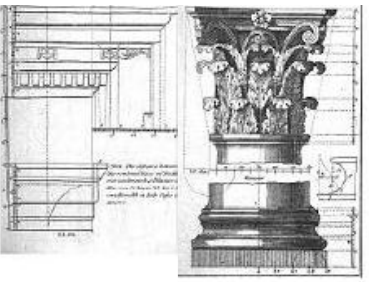
Figure 6: Pattern Book Detail – Corinthian